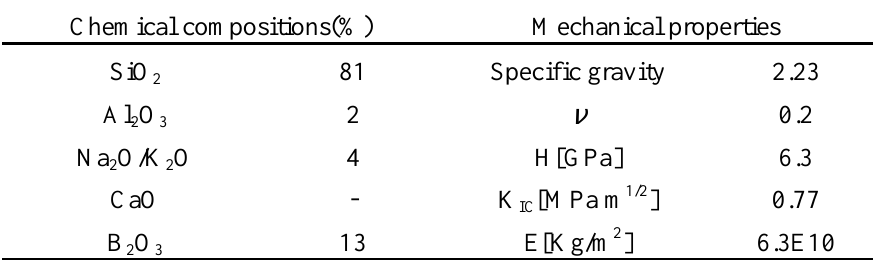
Table 1. Properties of the Pyrex glass.